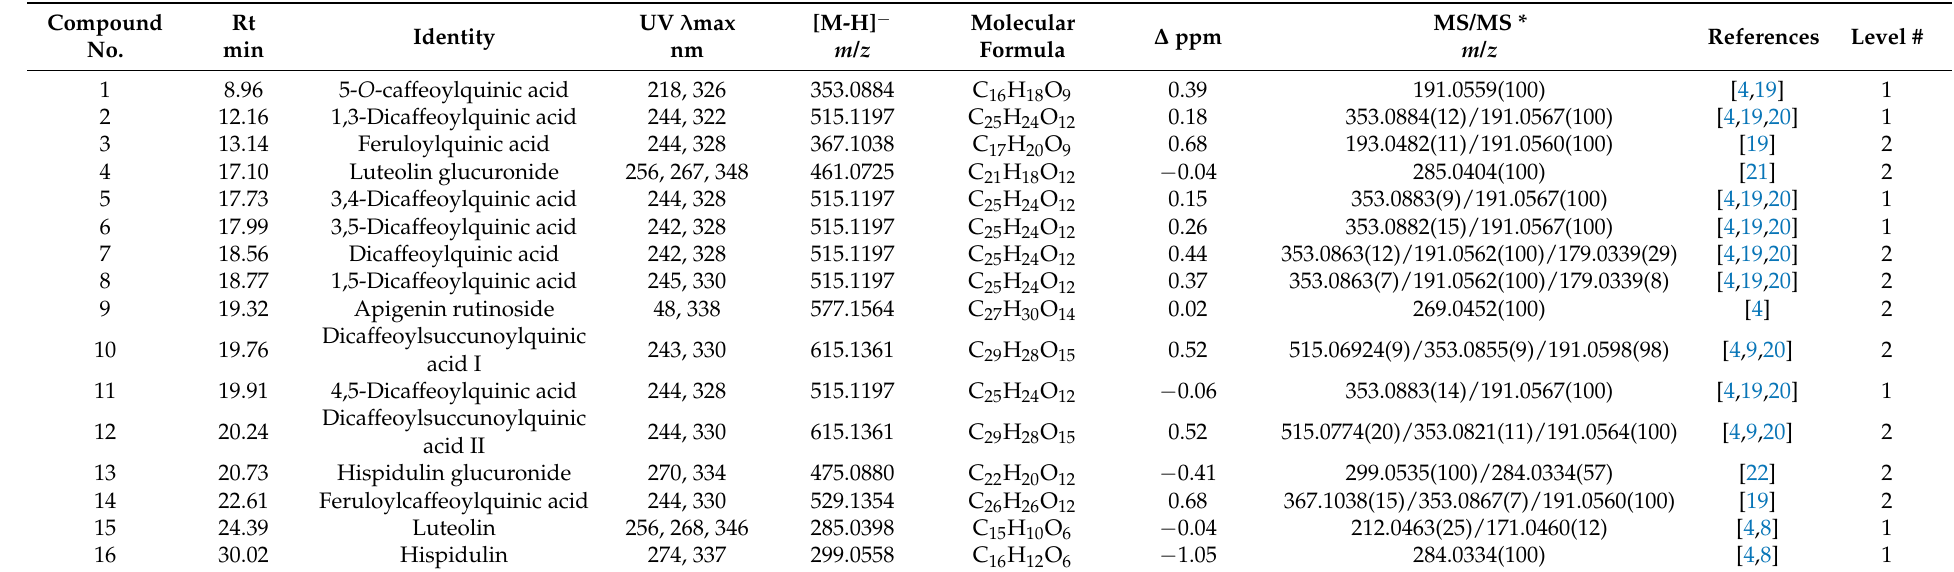
Table 1. Compounds identified by (HR) LC-ESI-QTOF MS/MS in O. illyricum